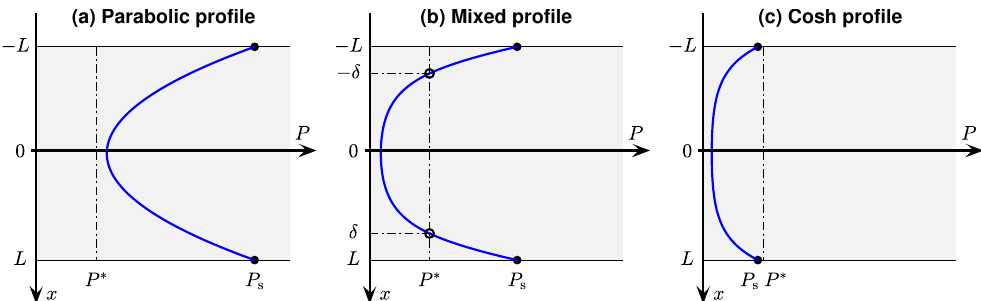
Figure 1. Representative P ( x ) solutions of Ivanova & Simeonov diffusion–consumption Equations (4) and (5), assuming a piecewise linear model (6) for consumption rate (see blue curve in Figure 2). Shading represents thin slab of tissue which extends from − L to L . Here, P s = surface pressure; P ∗ = critical pressure below which oxygen consumption is restricted; δ = depth at which pressure reaches critical value. ( a ) If minimum tension exceeds P ∗ , pressure profile is a simple parabolic function of depth. ( b ) If the pressure profile crosses the P ∗ boundary, the central portion forms a flattened hyperbolic-cosine (cosh) ‘basin’ that smoothly merges with parabolic ‘wings’ for P > P ∗ . ( c ) If the surface tension falls below the critical value, the cosh basin extends to the tissue